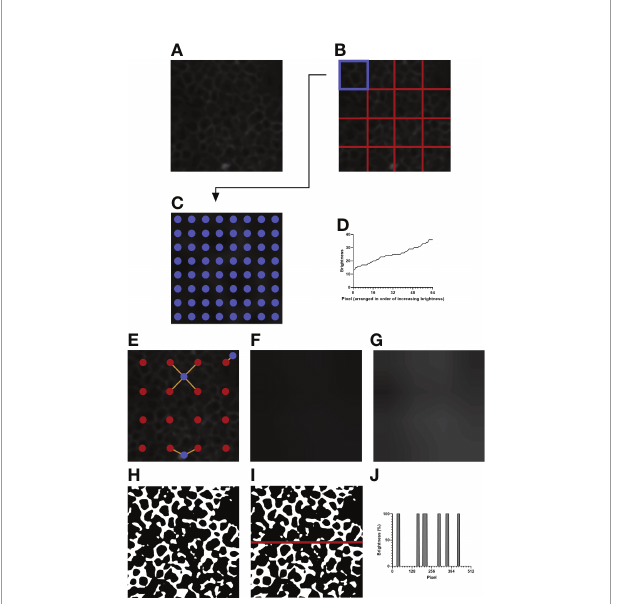
FIGURE 2 | An example of image processing. (A) The initial image after resizing and blurring. The green channel has been extracted. (B) The image is divided into 4 x 4 equally sized sections. (C) Depicted is the top left section of (B) , highlighted in blue. 8 x 8 evenly spaced pixels, highlighted in blue, are sampled for their brightness values. (D) The brightness values of the sampled pixels are arranged in increasing order. The brightness value of the 35 th pixel is taken as the normalization threshold value of the section. (E) Example pixels are highlighted in blue. Orange lines are drawn between each example pixel and their nearby section centers, marked in red. (F) The expected brightness map is created by calculating the distance-based weighted average of the normalization threshold values of nearby sections for each pixel in the image. The map predicts the background brightness value of a given pixel. (G) The brightness map in (F) is enhanced in Adobe Photoshop CC 2021 to improve visibility. The enhanced version is not used for analysis and is shown to highlight the differences in brightness in the image. (H) Pixels that are brighter than their expected brightness values are set to white, while all other pixels are set to black. (I) IJOQ analysis generally traces 10 horizontal and 10 vertical lines through the prepared image. An example line is shown on the image. (J) The brightness values of the pixels traced through the example line in (I) are measured. Each color change (i.e. vertical line) increments the cell border frequency by